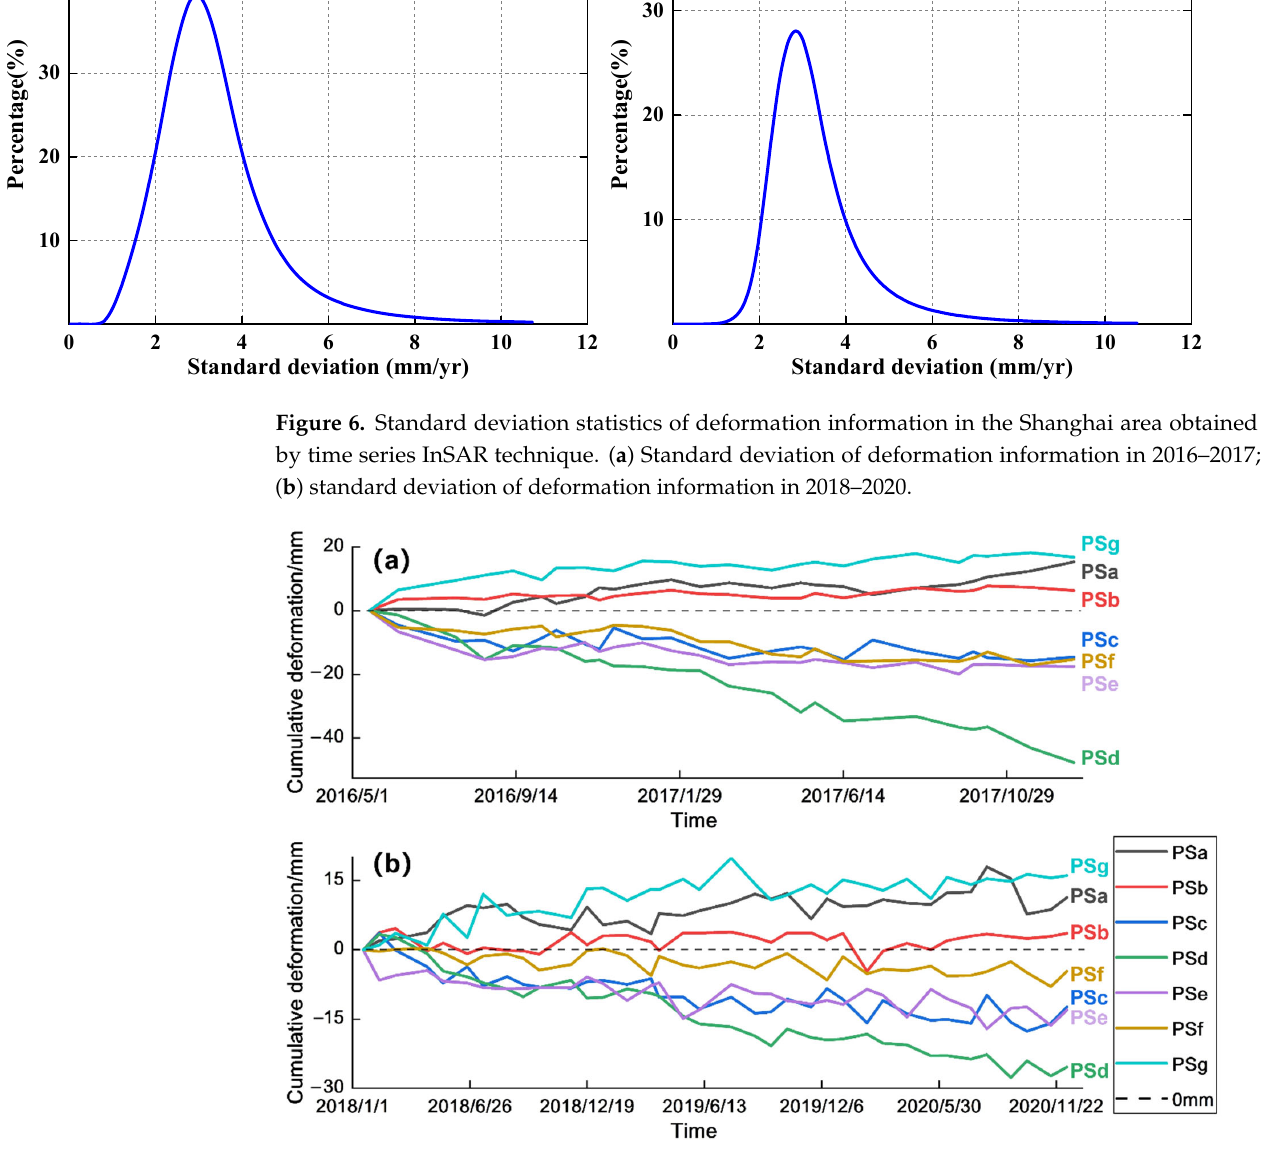
Figure 7. Changes in time series of feature points. ( a ) Cumulative subsidence changes of feature points a–g from June 2016 to December 2017; ( b ) cumulative subsidence changes of feature points a–g from January 2018 to December 2020. The black dotted line is the 0 mm deformation line.